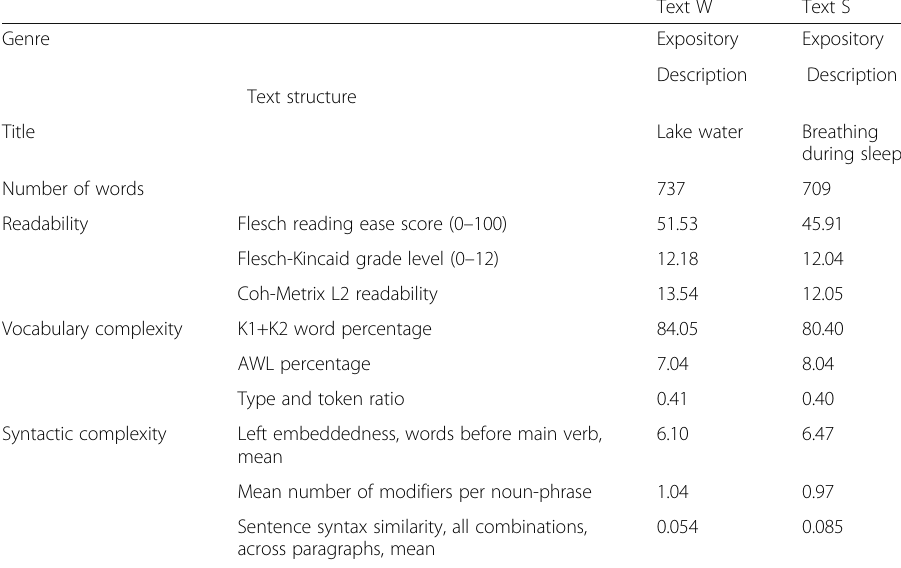
Table 2 Text analysis of reading